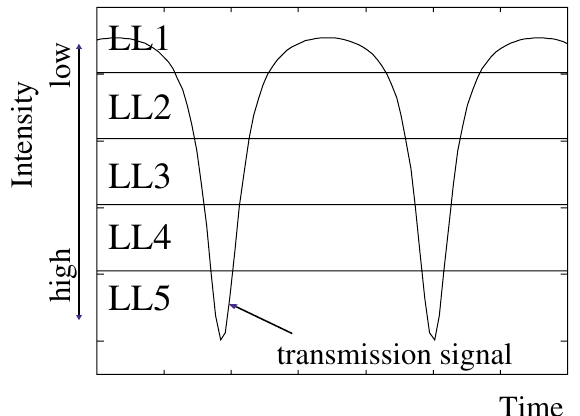
FIG. 4. (Color) Schematics of the transmitted laser signals and the MLC levels.